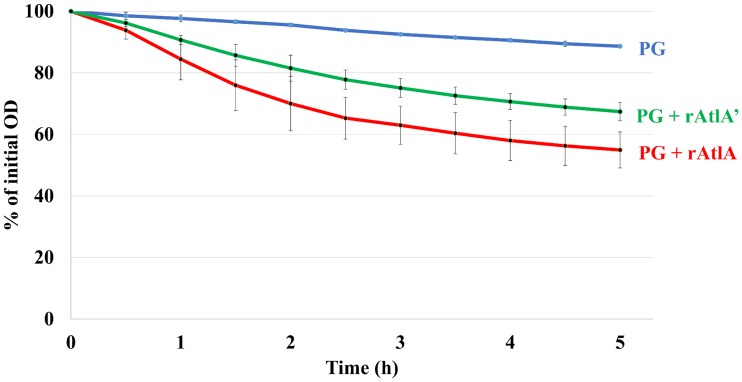
GelE-dependent AtlA cleavage does not significantly affect AtlA peptidoglycan hydrolysis activity.Equal molar concentrations (65 nM) of either recombinant full-length AtlA or AtlA’ were added to purified peptidoglycan and the peptidoglycan hydrolysis rate was measured by examining the of the solution every 30 minutes over a 5-hour time period. As a control, the hydrolysis rate for peptidoglycan alone was measured. Results are averages of three independent experiments. Error bars represent one standard deviation of the mean. Statistical significant differences (P < 0.05) in peptidoglycan hydrolysis were determined for PG + rAtlA and PG + rAtlA’ relative to PG only, using Student’s t test. No significant difference (P > 0.05) was determined for PG + rAtlA relative to PG + rAtlA’, using Student’s t test.